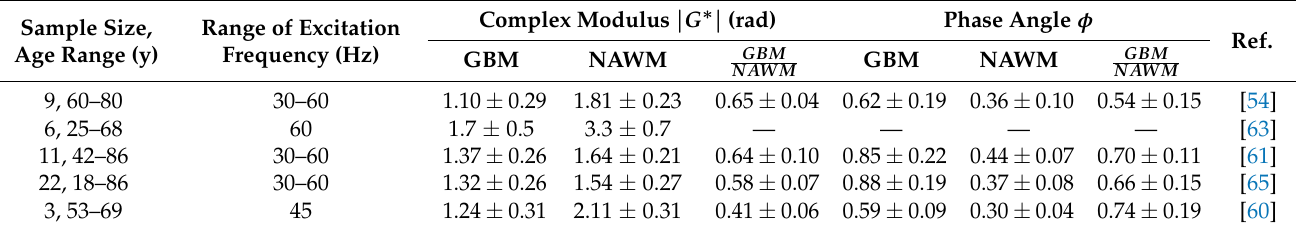
Table 1. The complex modulus | G ∗ | and phase angle φ in human GBM and NAWM measured using MRE, demonstrating its pre-operative diagnostic capabilities. Entries are presented in reverse date order. Sample